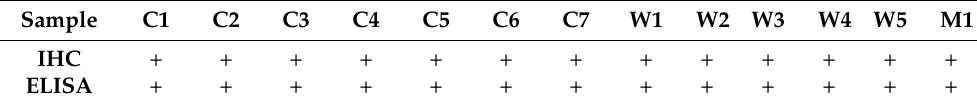
Table 6. IHC and ELISA immunoreactivity to different additive types in model meat products.